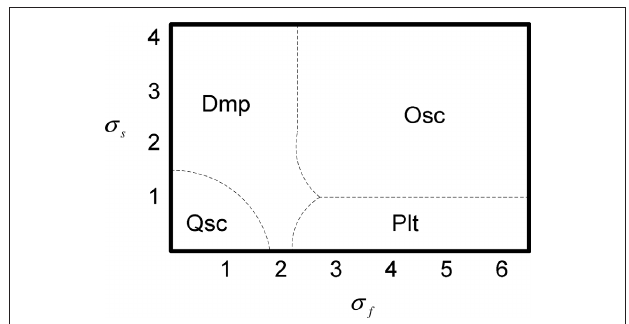
and σ . Qsc, quiescent; f s = 1 s, s